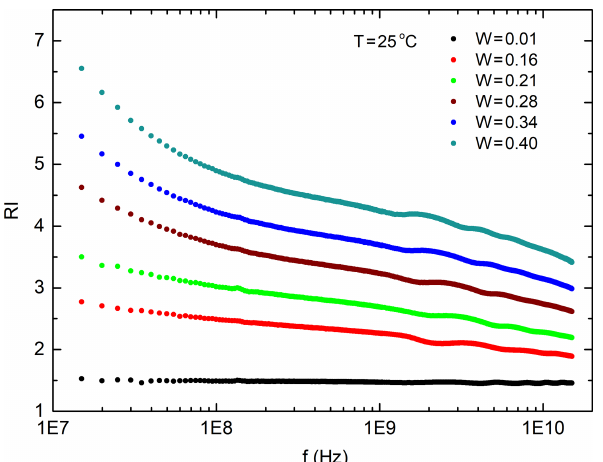
Figure 4. The refractive index (RI) for sample no. 6 (TM) depend- ing on the temperature of the soil sample ( T ) for various moisture levels at a frequency of f = 1.39GHz.